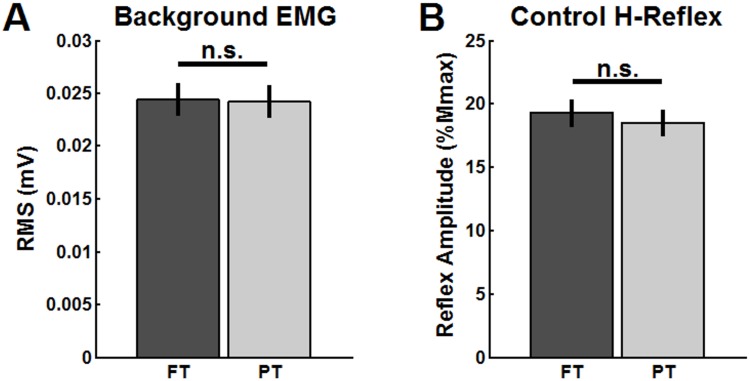
Amplitude of soleus EMG and control H-reflexes.(A) Average amplitude of soleus background EMG (expressed in mV) and (B) control H-reflexes (expressed in % of Mmax). Error bars depict within-subjects 95% CIs. There were no significant differences (n.s.) in soleus EMG activation and control reflex amplitudes between FT and PT trials (p>0.05).